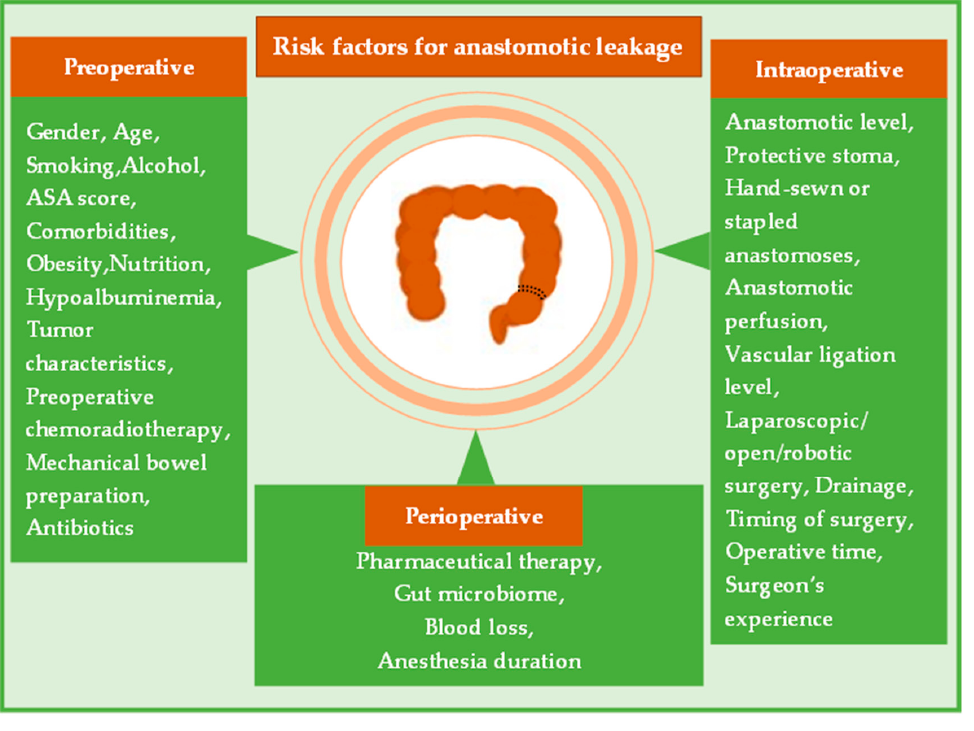
Figure 1. Multiple risk factors have been investigated so far concerning their impact on the incidence of postoperative ALs. Gaining a better knowledge of certain preoperative, intraoperative and perioperative factors could assist the surgeons’ intraoperative judgement and decision ‐ making.